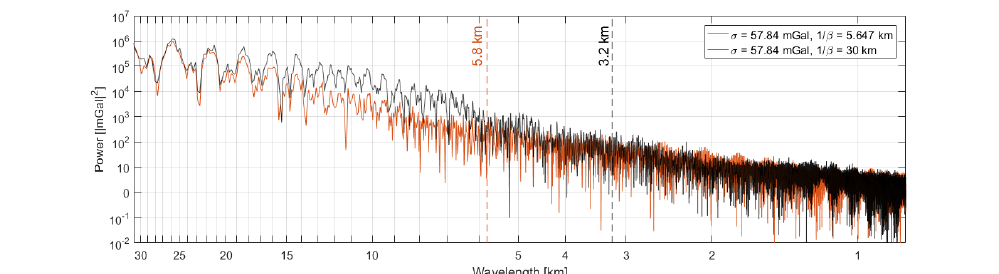
Figure 10. Power spectrum of the estimated gravity disturbance across the entire flight. The spectrum is also shown for the over-smoothed estimates and the estimated spatial resolutions are indicated by vertical